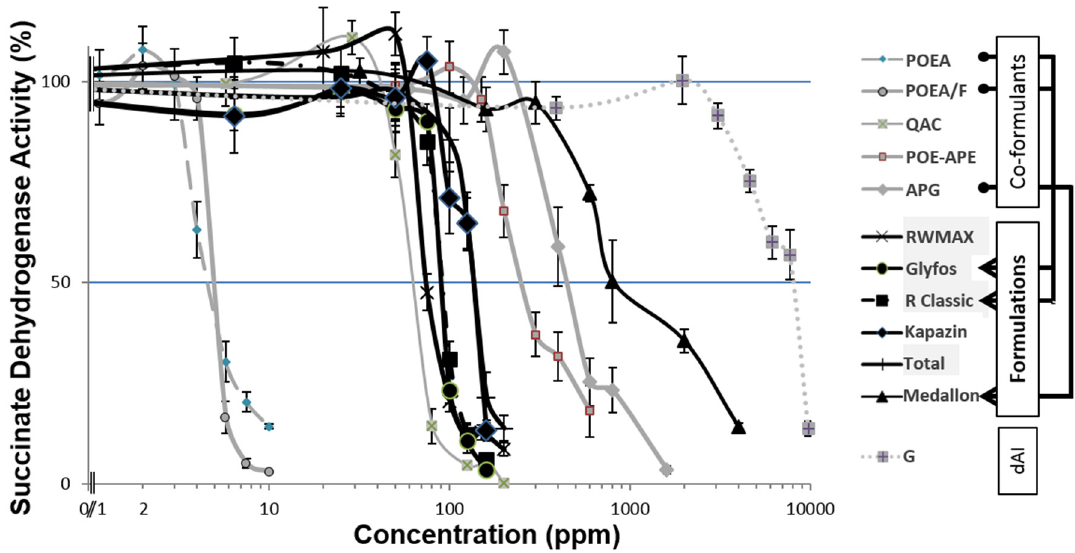
Figure 1. Dose-dependent cytotoxic effects of various glyphosate-based herbicide formulations or co-formulants or the declared active ingredient (dAI) glyphosate alone (G) in the JEG3 human cell line. Mitochondrial succinate dehydrogenase (SD) activities of JEG3 cells (% of the control values) were measured after 24 h exposure to formulations of glyphosate-based herbicides (GBH), their declared co-formulants alone or glyphosate (G) alone as following: A. The concentrations of POEA (9 ppm) and G (48.6 ppm) are those present in 100 ppm of Glyfos. B. The concentrations of POEA (18 ppm) and G (48.6 ppm) are those present in 100 ppm of R Classic. C. The concentrations of APG (800 ppm) and G (975 ppm) are those present in 2000 ppm of Medallon. D. 100 ppm of the formulations (R WeatherMAX – R WMAX –, Glyfos, R Classic, Kapazin, and Total) are compared to 100 ppm of two co-formulants (QAC and POE-APE) and glyphosate alone (G). All data are the mean ˘ standard error of the mean (SEM). All the experiments were repeated three times in triplicate. Statistically significant differences from the controls were determined by a Kruskal-Wallis nonparametric test followed by a post hoc test using significant levels of 0.05 (*), 0.01 (**) and 0.001 (***). G is isopropyl ammonium salt of glyphosate. C: Control; R: Roundup.